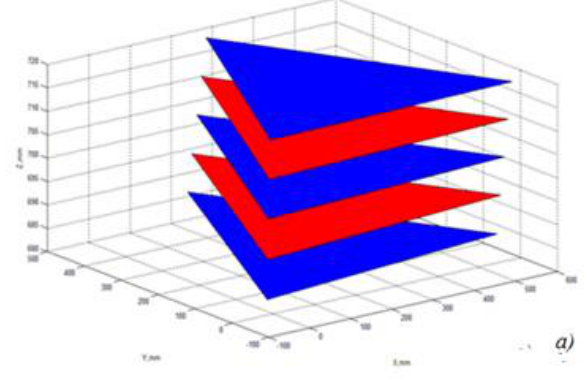
Figure 2. Diagram of the PMC top platform movement 3. Defining PMC